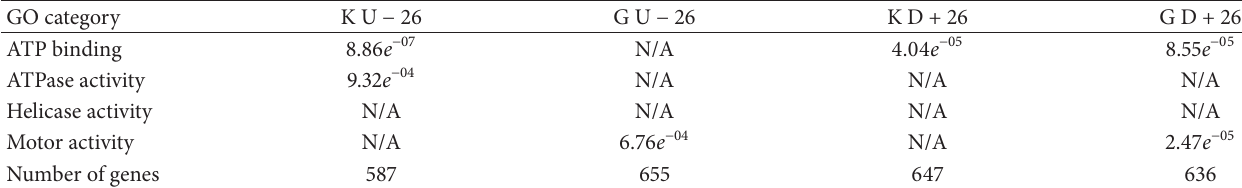
Table 2: 𝑃 values indicating significance of ontological enrichment for genes exhibiting the U − 26 or D + 26 feature in vivo . GO